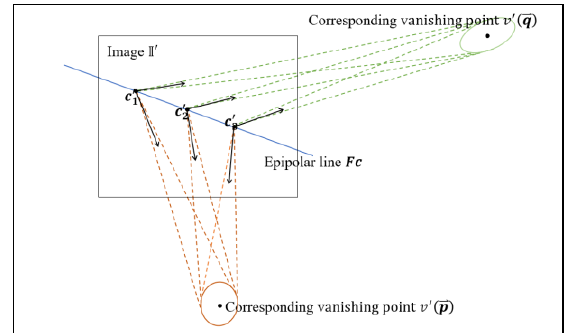
Figure 3. Searching the corresponding L-junctions under epipolar-geometry and constraints of two vanishing-points.